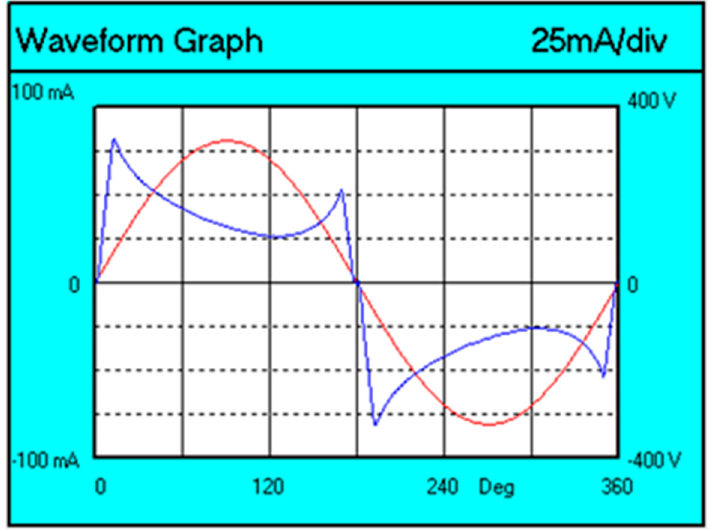
Figure 5. Voltage and current waveforms for the A60 Graphene lamp. You can see that the current waveform (blue line) is not sinusoidal.